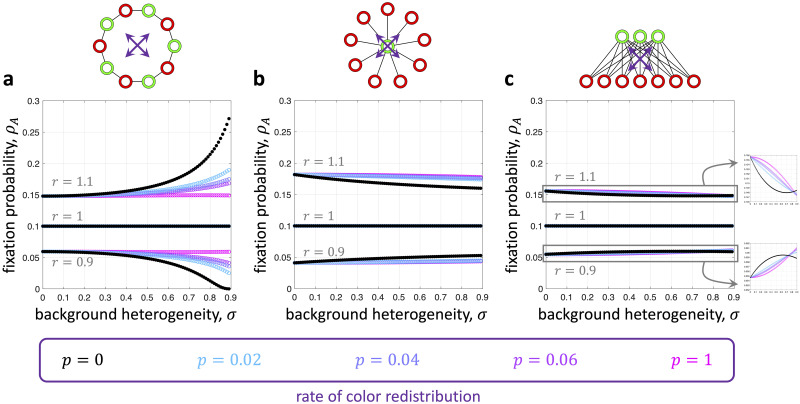
Fixation probability in the presence of dynamic resources on bipartite graphs.ρA is shown here as a function of resource heterogeneity, σ, for several values of the resource redistribution rate, p, and mutant mean fitness, r. The population initially has a proper two-coloring. At each time step, with probability p the colors are shuffled according to permutation chosen uniformly at random. With probability 1 − p, the coloring is not changed in that time step. In a and b, high environmental fluctuations (i.e. large p) attenuate the effects of background heterogeneity relative to the initial distribution of resources at p = 0 (corresponding to a proper two-coloring, shown in black and given by Eq 2). In c, this behavior holds for all but the highest levels of background heterogeneity. The fixation probabilities in all panels were approximated by building transition matrices for each process and looking at the exact distribution after 107 steps.